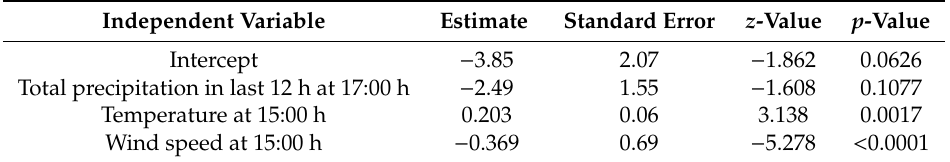
Table 1. Results of the generalized linear model (GLM) based on a Poisson distribution testing the e ff ect of weather conditions on the daily number of grasshoppers taking o ff . Independent Variable Estimate Standard Error z -Value p -Value Intercept − 3.85 2.07 − 1.862 0.0626 Total precipitation in last 12 h at 17:00 h − 2.49 1.55 − 1.608 0.1077 Temperature at 15:00 h 0.203 0.06 3.138 0.0017 Wind speed at 15:00 h − 0.369 0.69 − 5.278 <